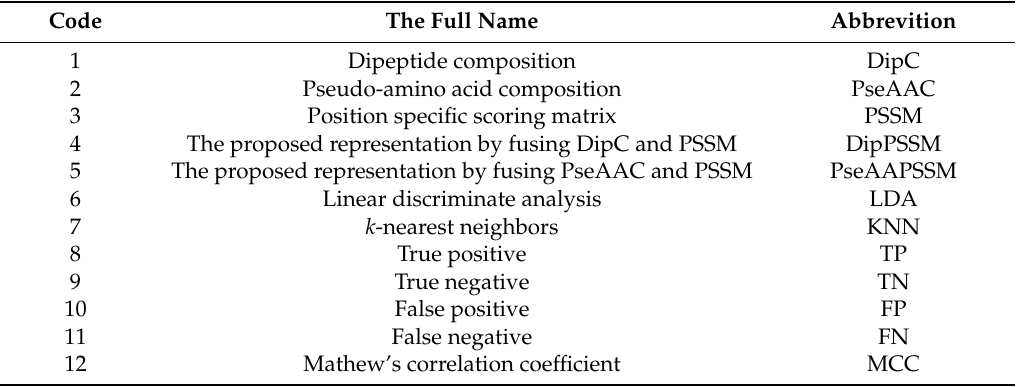
Table 1. The corresponding relationship between abbreviation and full